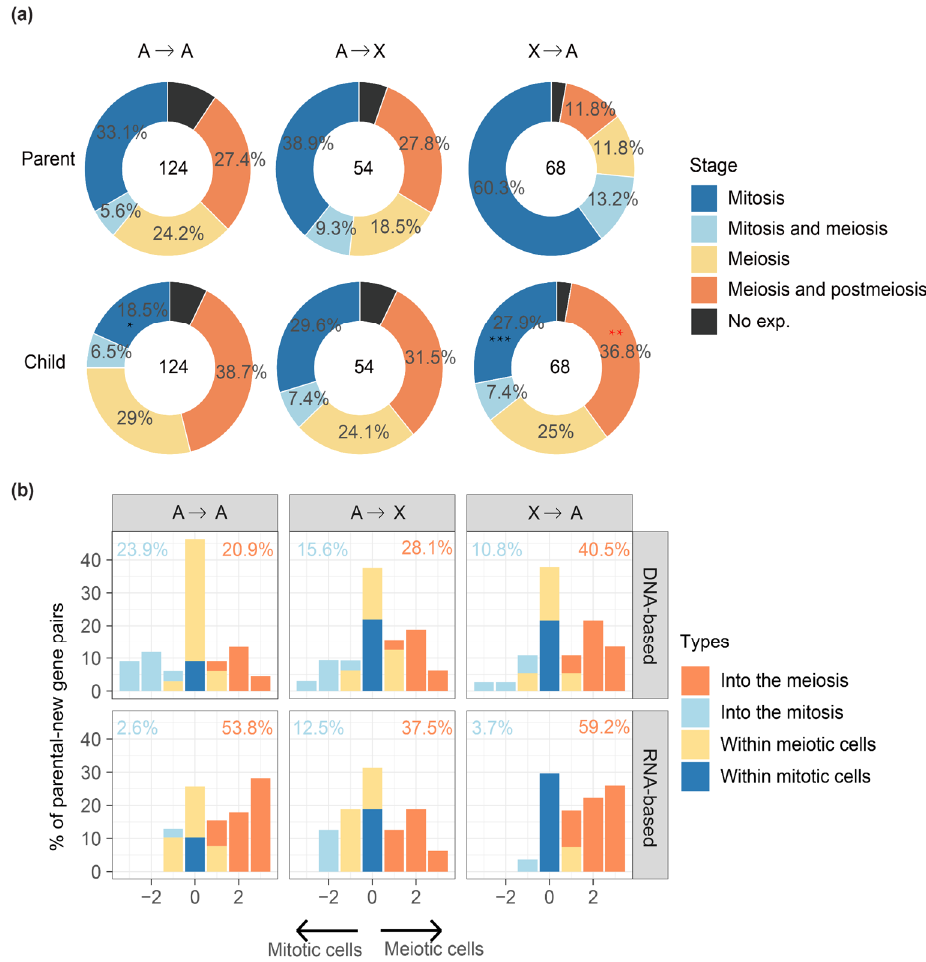
Figure 3. Comparing the testis cell type differences between parental and new genes. ( a ) Comparing the testis cell composition between the parental and new genes divided by their relative chromosomal positions. We divided the parental–new gene groups into: ‘A to A’ (an autosomal parental gene produces an autosomal new gene), ‘A to X’ (an autosomal parental gene produces an X-linked new gene), ‘X to A’ (an X-linked parental gene produces an autosomal new gene). Red asterisks mean significantly enriched; black asterisks mean significantly underrepresented. “*”: p < 0.05, “**”: p < 0.01, “***” p < 0.001. ( b ) We further cross-examine the three types of inter-chromosomal parental–new gene pairs regarding their different origination mechanisms as either DNA-based or RNA-based duplications. The x-axis shows the extent and direction of testis cell type changes between the parental and new genes. We labelled the genes annotated to be predominantly expressed at one or two types of germline cells (Figure 1b) from spermatogonia to spermatids as 1 to 4. If a parental gene that is expressed mainly in spermatogonia (cell type 1) or both spermatogonia and early spermatocytes (cell type 2) shows a positive value of cell type change for its new gene, it is defined as showing an ‘into the meiosis’ change. Similarly, we can also define cell type changes as ‘within the meiotic cells’ or ‘within the mitotic cells’ if the new and parental genes differ by 1 or less, and as ‘into the mitosis’ if the difference is a negative value and the new gene is predominantly expressed in spermatogonia (cell type 1 or 2). We show the percentage of ‘into the meiosis’ gene pairs in orange, and that of ‘into the mitosis’ in blue for each category.